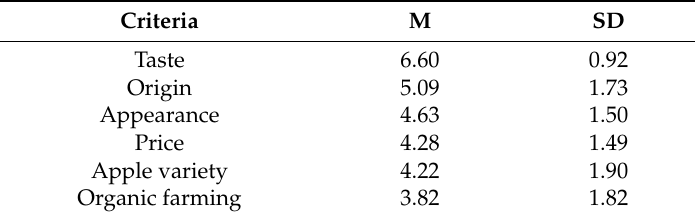
Figure A2. Text box used in the survey to inform participants about the relevance of Se in human nutrition and the need to improve dietary Se intake. Table A1. Importance of purchasing criteria for apples.